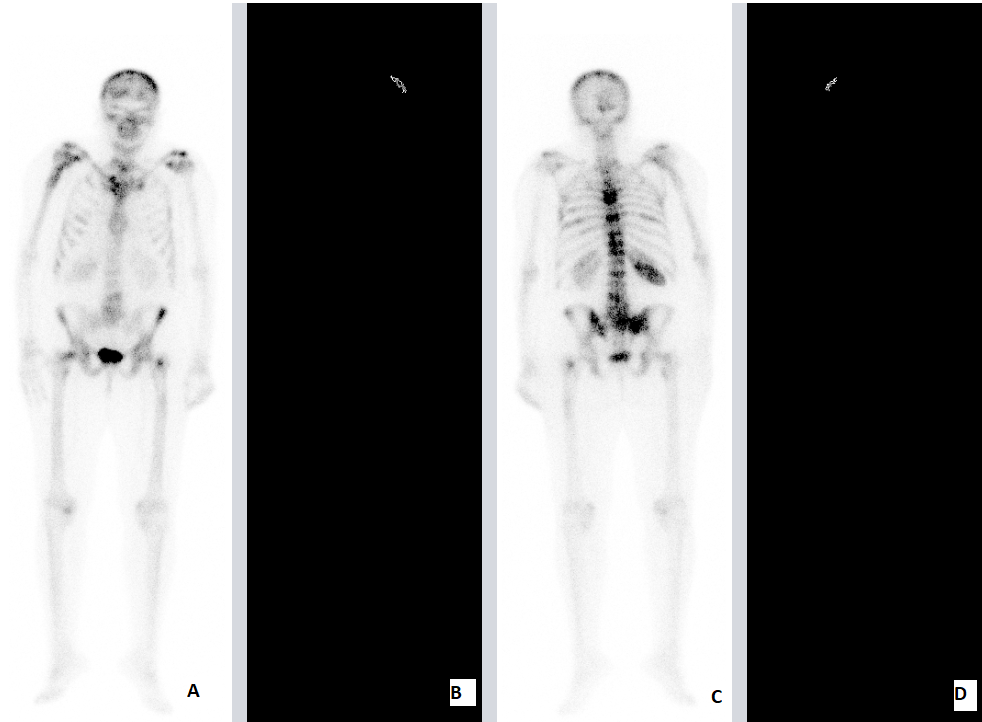
Figure 3. Same female breast cancer patients as in Figure 2 after RT. The RT sites were thoracic and lumbar vertebrae. Note the reduction of metastasis on the skull. ( A ) Bone scintigraphy, anterior; ( B ) Dascis software, anterior, ROI on skull; ( C ) bone scintigraphy, posterior; ( D ) Dascis software, posterior, ROI on skull.